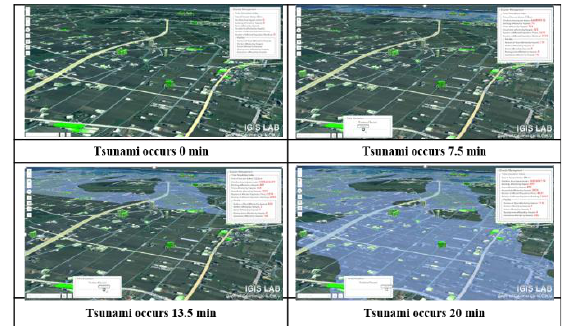
Figure 12. Tsunami run-up synchronous analysis and